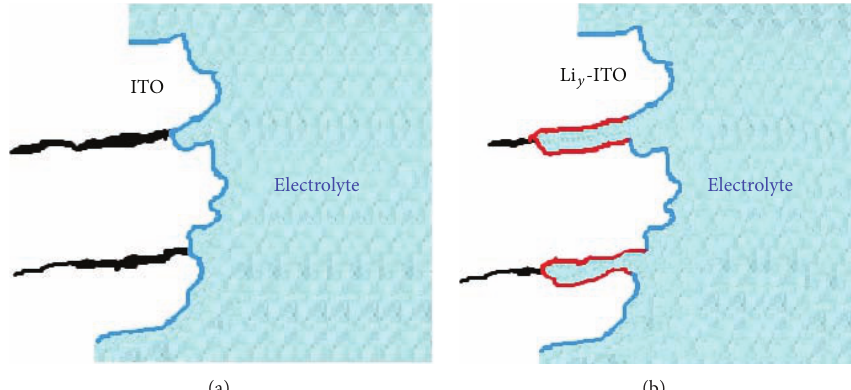
Figure 2: Schematic depiction of the morphological evolution of the ITO/electrolyte interface upon electrochemical cycling and consequent lithiation of the oxide. Blue lines represent the surface sections of (a) pristine ITO and (b) Li 𝑦 -ITO grains which are exposed to the electrolyte. Black lines in (a) and (b) represent the grain borders of the electrode (sectional view), which are not in contact with the electrolyte prior to lithiation. Red lines in (b) represent the expansion of the Li 𝑦 -ITO/electrolyte interface (sectional view) with respect to the interface of pristine ITO prior to electrochemical cycling.